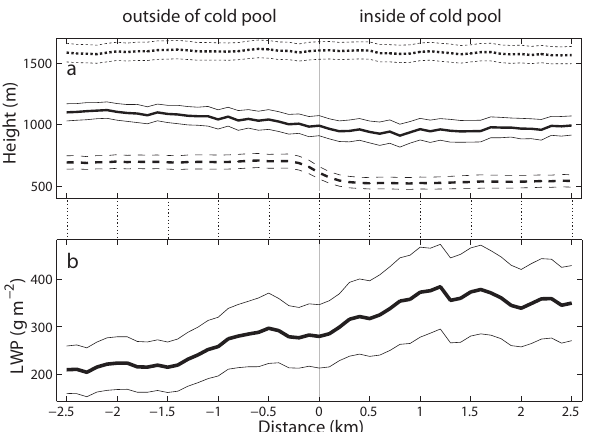
Fig. 13. Composites of cloud properties: (a) cloud top height (dot- ted), cloud base height (solid), and lifting condensation level (LCL; dashed); (b) cloud LWP retrieved by the GVR. The variables in ( a and b ) are composited without taking the anomalies in relation to the cold-pool edge. Bold and thin lines are mean and 95% confi- dence intervals of the mean. Fig. 14. Composites of (a) column maximum reflectivity ( Z